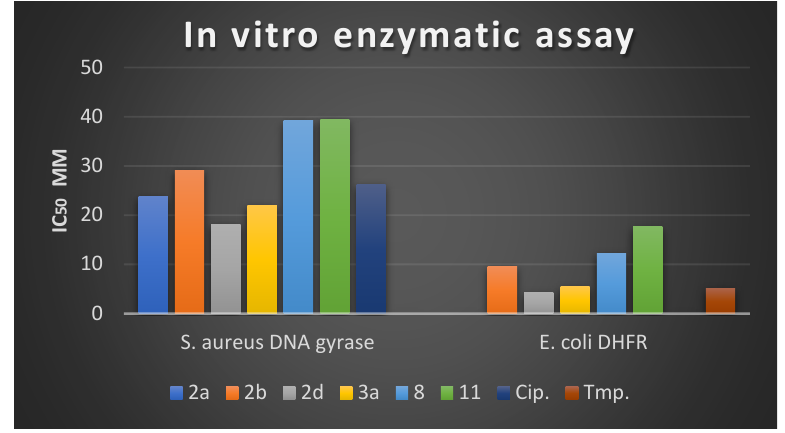
Figure 2. Graphical representation of the in vitro S. aureus DNA gyrase and E. coli DHFR enzymatic assay IC 50 (µM) of the most promising derivatives compared to ciprofloxacin and trimethoprim.